Question: Identify the chart type used in this figure.
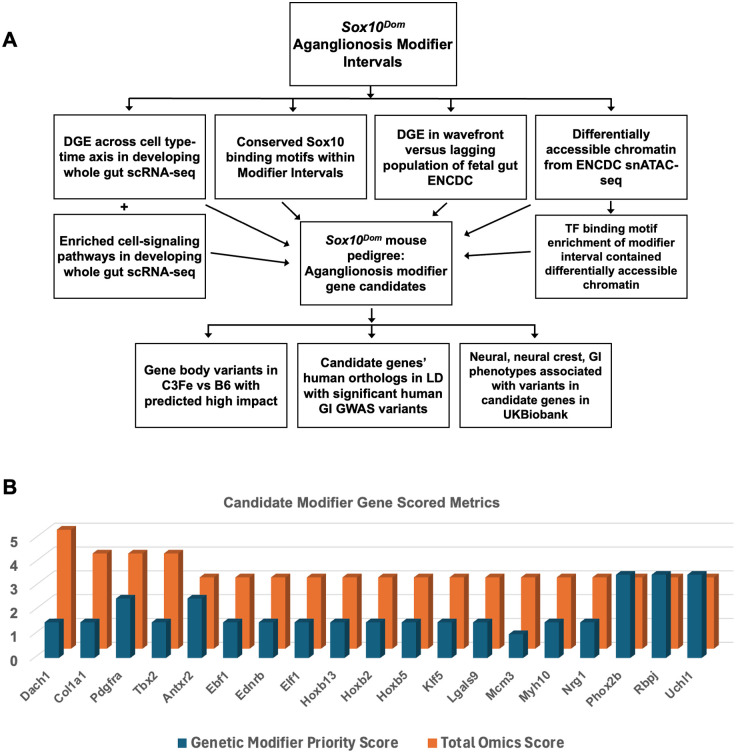
Answer: bar